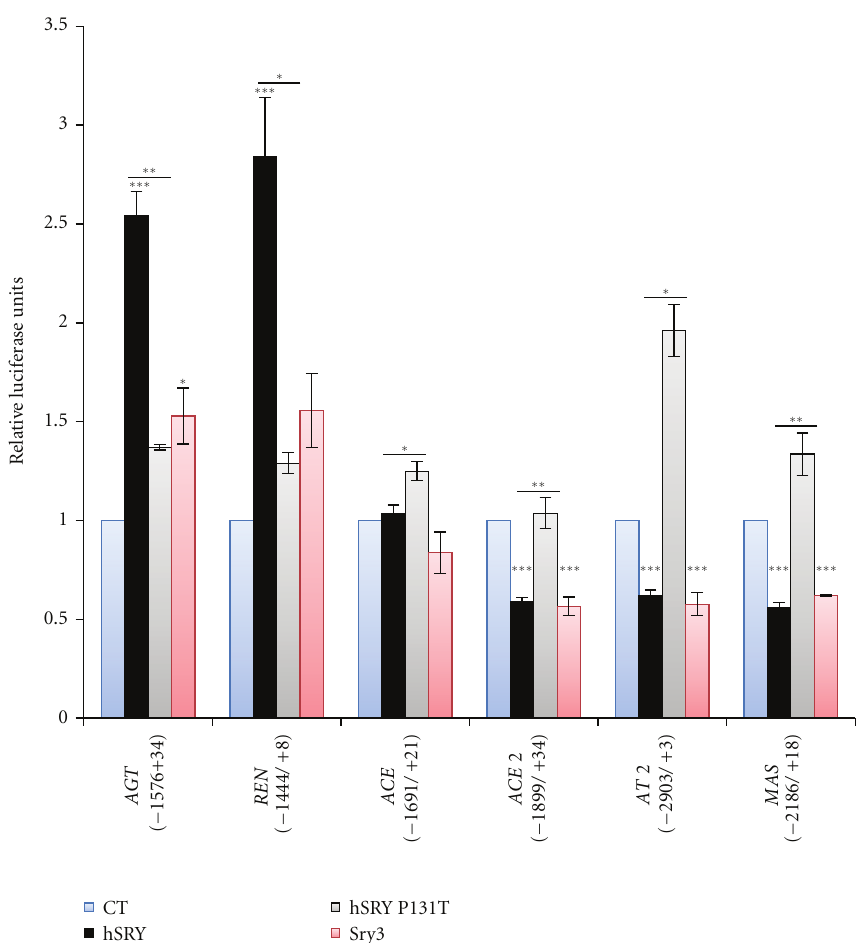
Figure 4: Human SRY regulation of the human RAS gene promoters. Human SRY (hSRY, black) significantly regulated human AGT , REN, ACE 2, AT2 , and MAS promoters. Significance of hSRY is based on comparison to the control vector (blue). The mutation at amino acid 131 (hSRY P131T, gray) significantly diminished function in AGT, REN , ACE 2, AT2 , and MAS constructs relative to hSRY. Sry3 (red) significantly regulated AGT, ACE2, AT2 , and MAS compared to control (blue). ∗ P ≤ 0 . 05, ∗∗ P ≤ 0 . 01, ∗∗∗ P ≤ 0 .